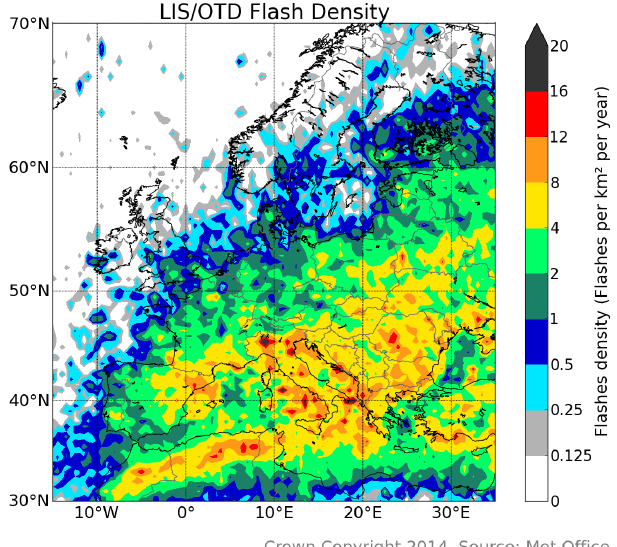
Fig. 2. Estimated European flash density obtained using data from the OTD and LIS